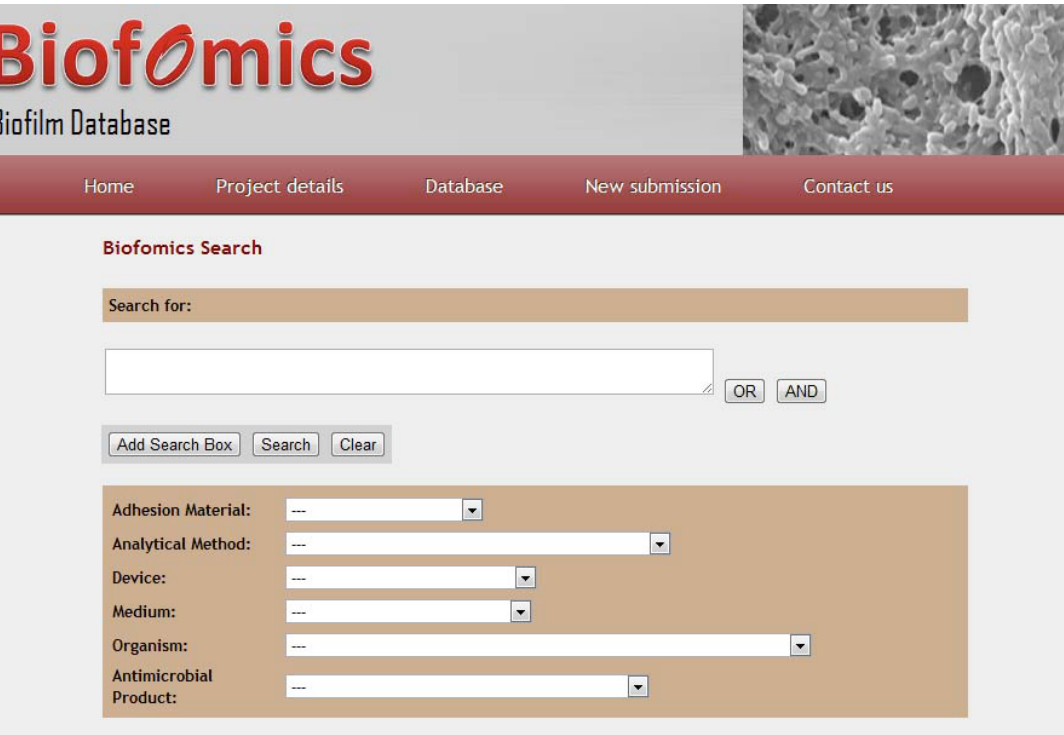
Fig. 5: BiofOmics facility for public biofilm data